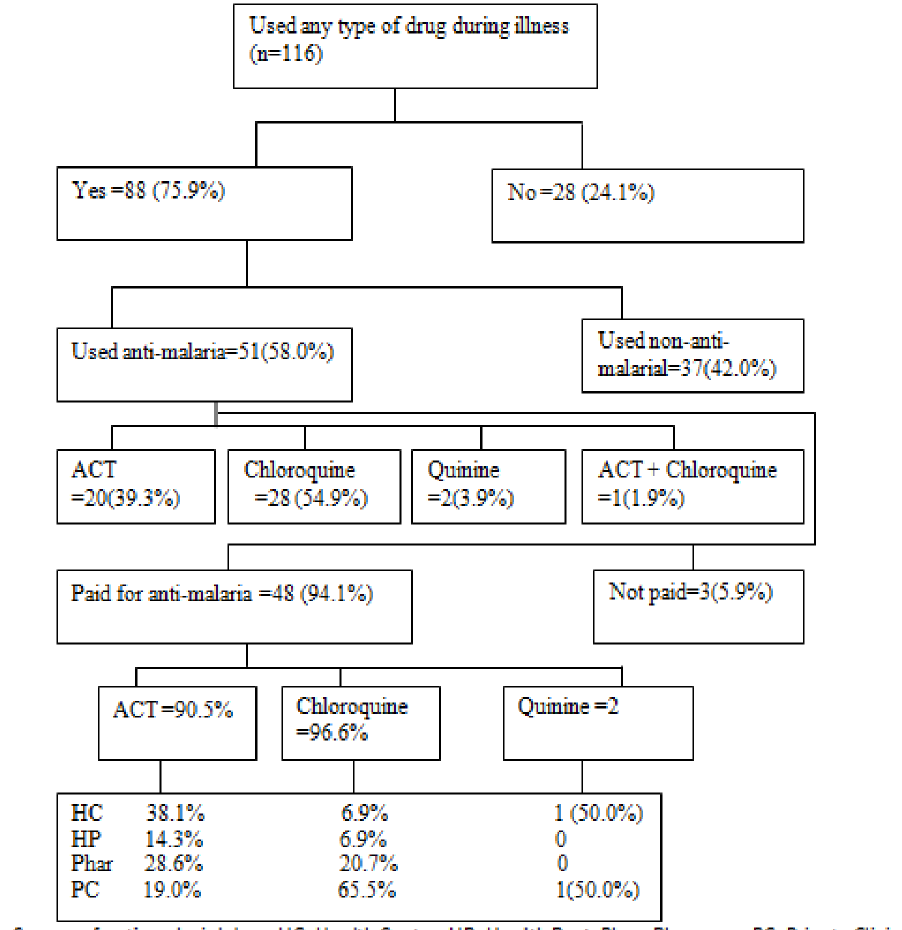
Fig 5. Anti-malarial drug use amonspeople with fever, Jimma. Jan2014. Of the household members who reported having fever, 88 (75.9%) used certain type of drug. However, only 51 (58.0%) used anti-malaria drugs and the remaining used non-anti-malarial drugs such as antipyretics, antibiotic and others. Of those who received anti-malarial drugs, 28(54.9%) received Chloroquine followed by ACT which accounted for 20 (39.3%). The majority (94.1%) of those who used anti-malarial drugs reported that they paid for it. Private clinics (45.1%), pharmacies (23.5%) and health centers (21.6%) constituted the major source of anti-malarial drugs. Only (9.8%) of those who used anti-malarial drugs obtained it from community health posts.